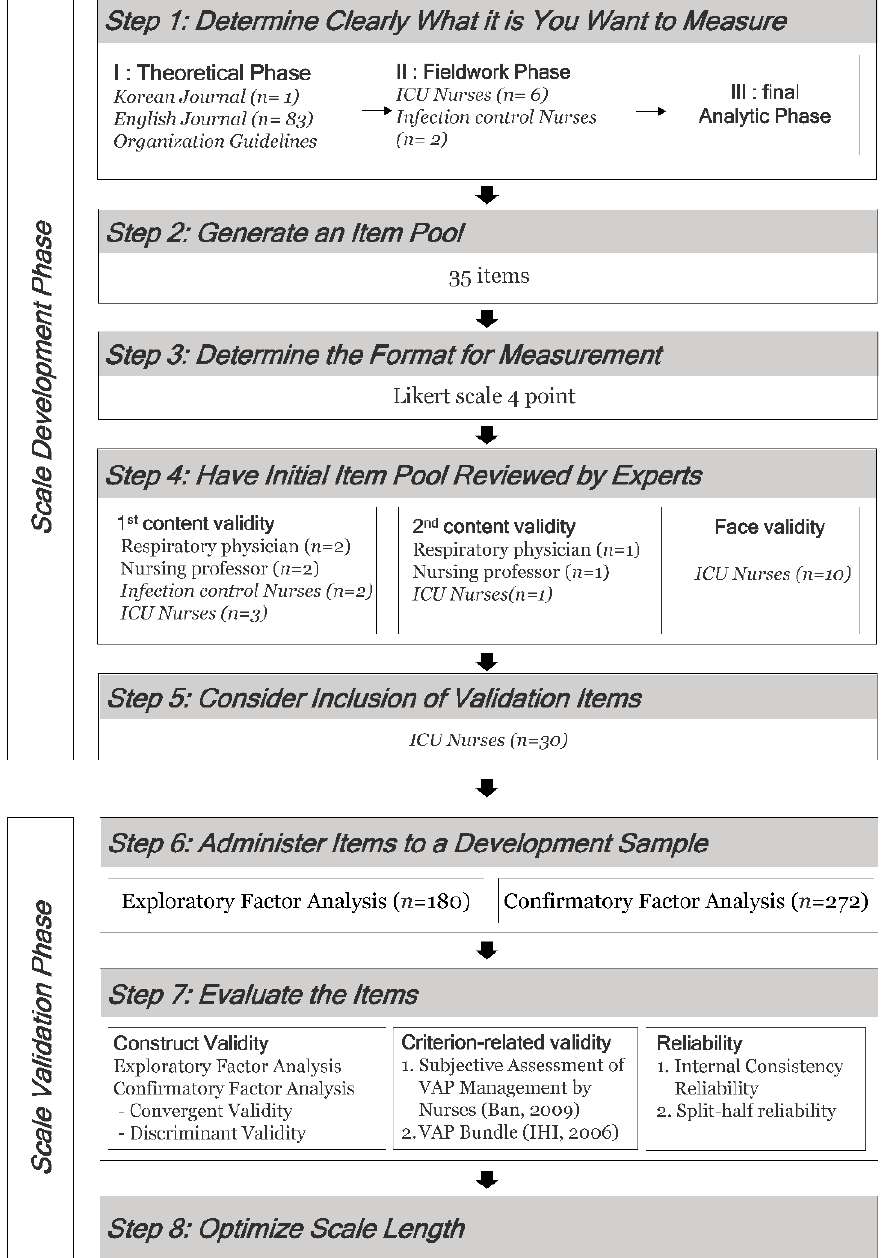
Figure 1. Research design and methods (Ban, 2009 [27], IHI, 2006 [6]).